Question: Generate an informative caption for the figure above.
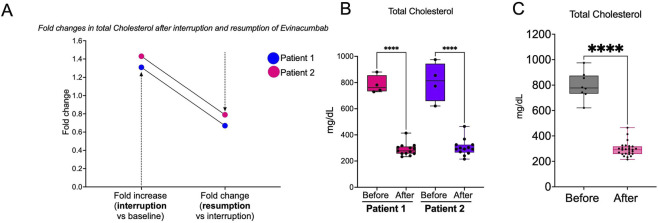
Answer: Effect of Evinacumab interruption and reintroduction on total cholesterol. (A) Fold changes in total cholesterol following treatment interruption and after resumption of Evinacumab comparing both patients side by side. Interruption resulted in a fold increase in cholesterol levels relative to baseline, whereas reinitiation led to a fold reduction relative to interruption levels. (B) Total cholesterol concentrations before and after Evinacumab initiation in each patient. Box plots represent distribution of measurements during each phase. Statistical significance is indicated (****p < 0.0001; ns, not significant). (C) Overall comparison of total cholesterol levels in the two reported patients before and after Evinacumab therapy. Treatment was associated with a significant reduction in total cholesterol (****p < 0.0001). Data are expressed in mg/dL. Statistical analysis was performed using paired comparisons.